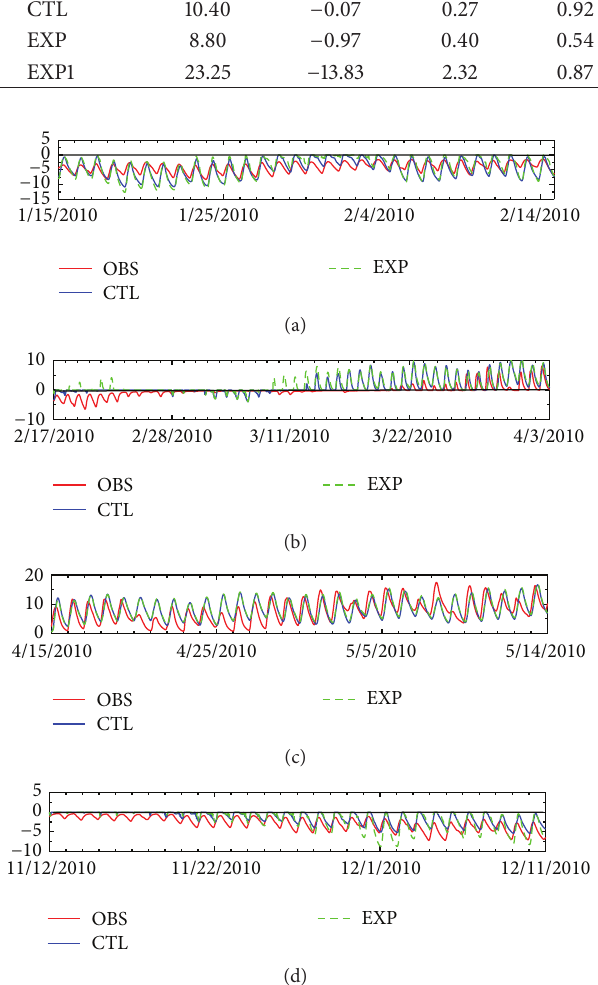
Figure 10: Diurnal variations of soil temperature in the 10cm soil layer in four freeze-thaw stages in the ZS site. (a) Completely frozen, (b) thawing, (c) completely thawed, and (d) freezing.